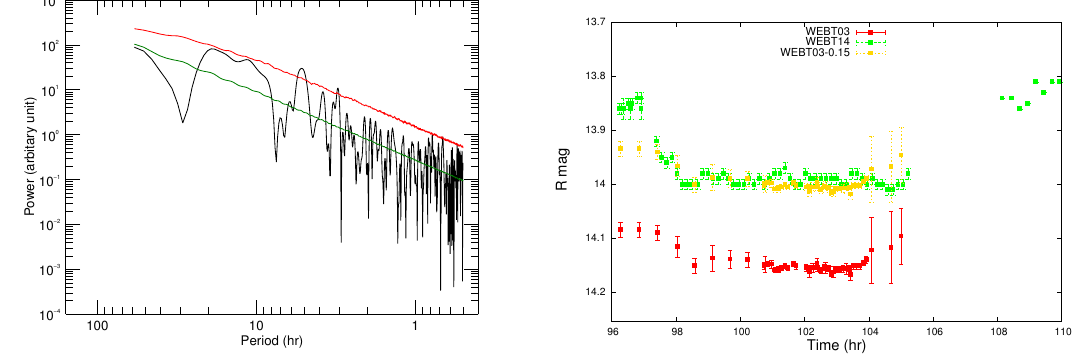
Figure 3. ( Left ): Lomb–Scargle periodogram (black) with simulated average periodogram (green) and 99% confidence level (red); ( Right ): A ∼ 6 h plateau of diminished variability seen in the light curve (green) and a similar episode from WEBT 2003 (red, yellow) [18].